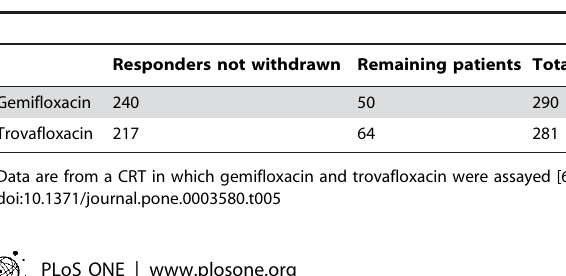
Table 5. Expected frequencies combining efficacy and safety distributed according to the template shown in Table 3.